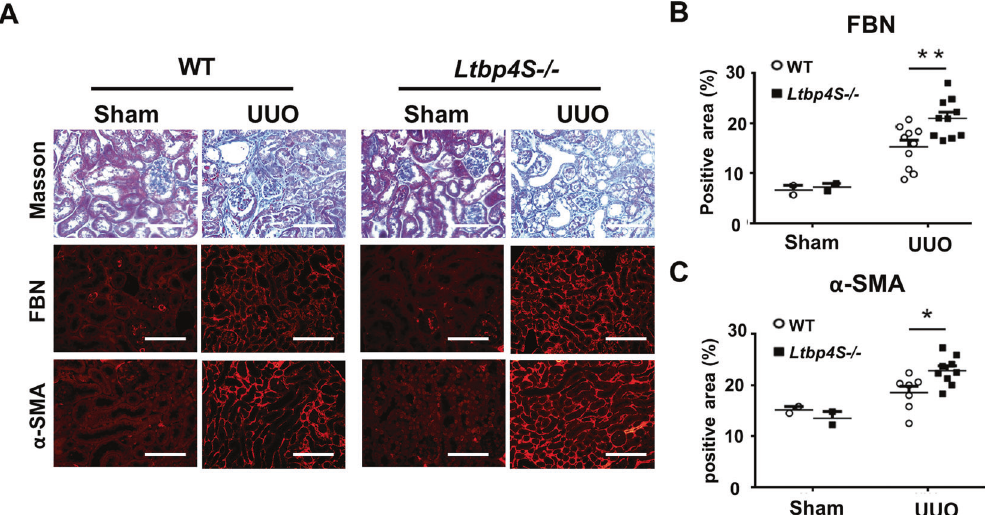
Fig. 2 Ltbp4 S de fi ciency aggravates tubulointerstitial fi brosis in mice. Wild-type (WT) and Ltbp4S knockout ( Ltbp4S − / − ) mice were subjected to unilateral ureteral obstruction (UUO) to induce tubulointerstitial fi brosis for fi ve days. A Representative histological images with Masson ’ s trichrome and immuno fl uorescence staining of kidneys after UUO. Scale bars, 100 μ m. Computer-assisted quantitative analyses of histological images for fi bronectin ( B ) and α -SMA ( C ) are shown. Data are presented as the mean ± SEM. n = 8 – 10 mice per group. * p < 0.05, ** p <